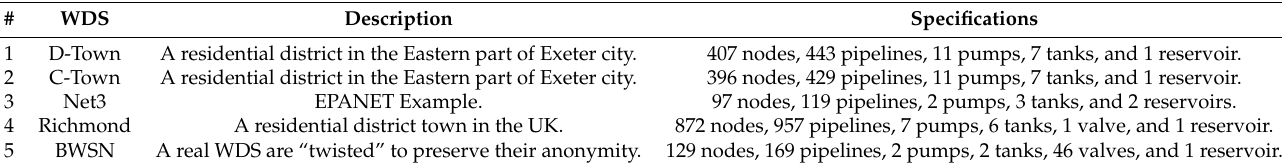
Table 2. Case-study